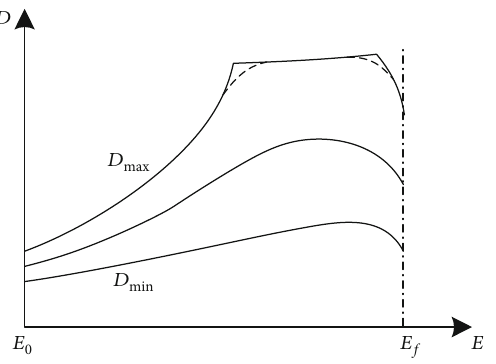
Figure 7: Maximum downrange and minimum downrange drag pro fi